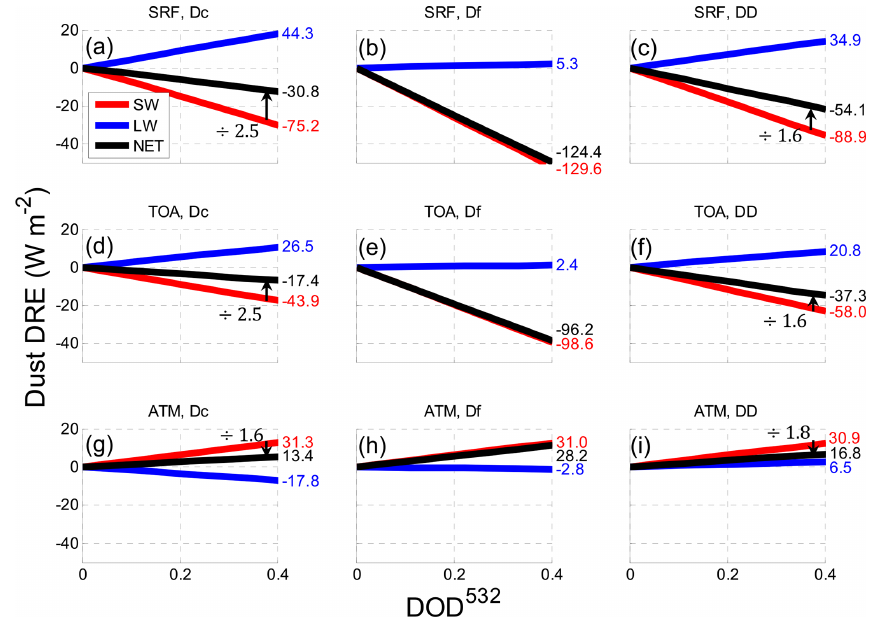
Figure 12. Linear fitting of the dust direct radiative effect (SW, LW and net) as a function of DOD 532 at SRF for (a) Dc, (b) Df and (c) DD; at TOA for (d) Dc, (e) Df and (f) DD; and in the atmosphere for (g) Dc, (h) Df and (i) DD in BCN (23–30 June). Corresponding DREff values (slope of the linear fitting of DRE vs. DOD 532 ) are included next to the right axis (DREff units areWm − 2 τ − 1 ). In Dc and DD plots the arrows and number indicate the SW / net ratio. The legend in (a) applies to all